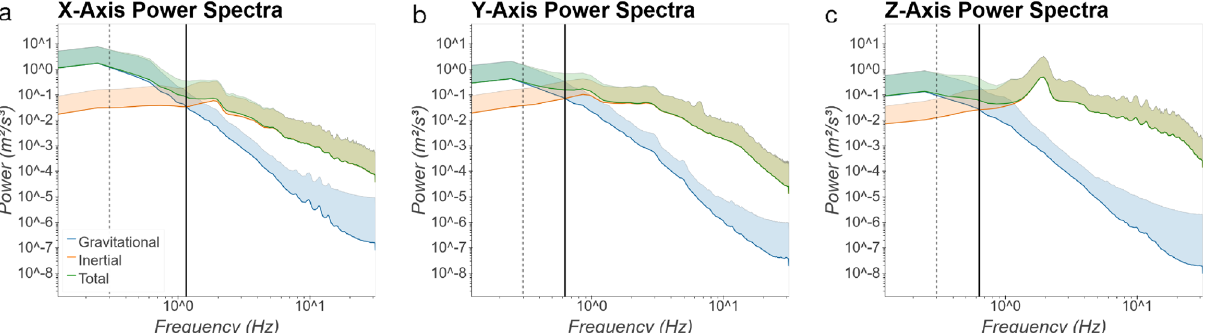
Figure 3. Power spectra for gravitational (blue), inertial (orange), and sum total (green) linear acceleration along X- (nasal-occipital), Y- (interaural), and Z- (dorsal-ventral) axes. Figure axes are log-scaled. Crossing points in power between gravitational and inertial acceleration are observed at 1.148, 0.626, and 0.633 Hz for X-, Y-, and Z-axes, respectively (black). Previously observed crossing points at 0.3 Hz from 24 are plotted for comparison (dashed grey).